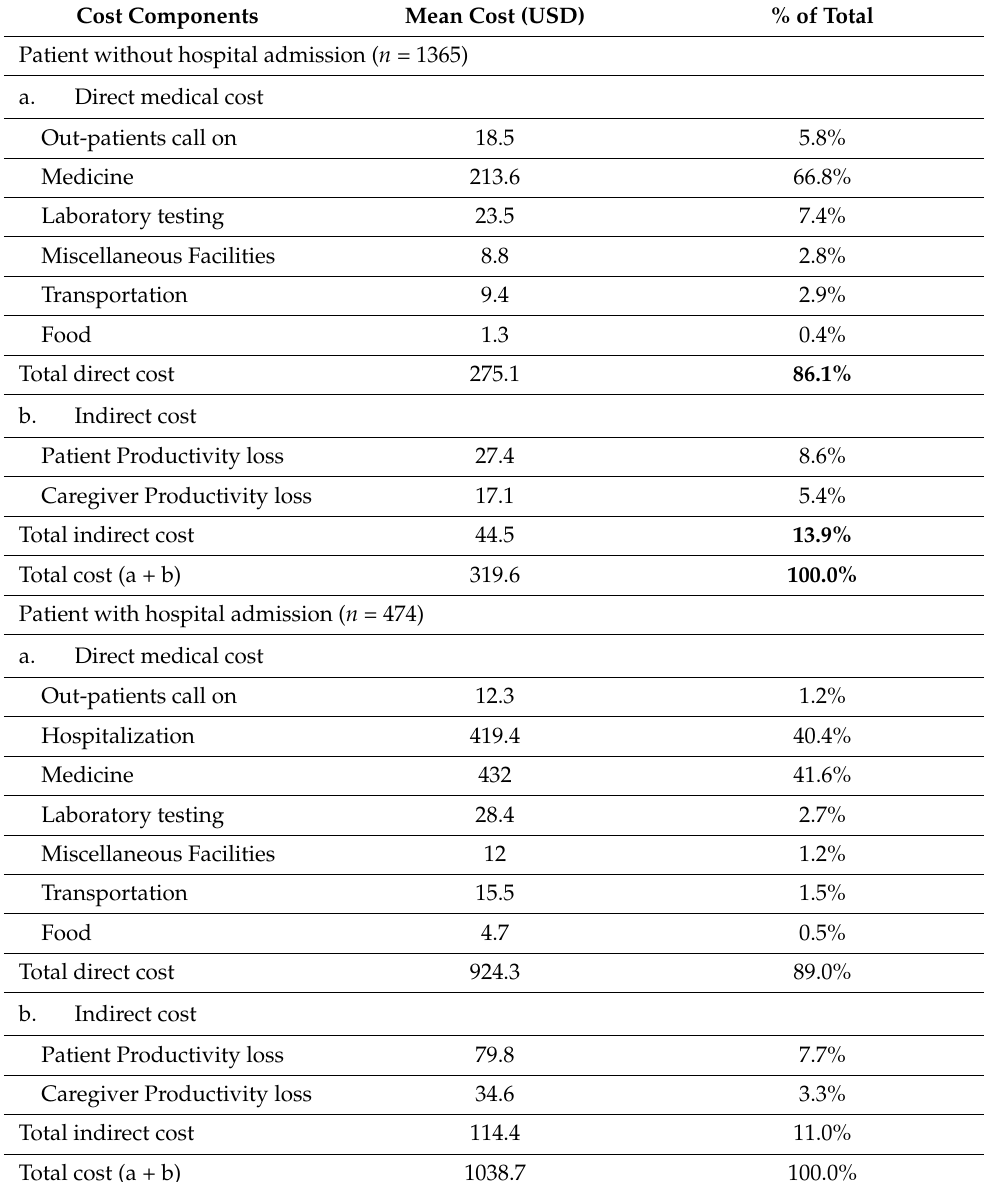
Table 5. The difference in the mean direct and indirect costs of diabetes care among hospitalized and non-hospitalized population.